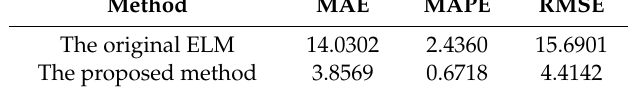
Table 6. Metrics of comparison experiments (Group 2).